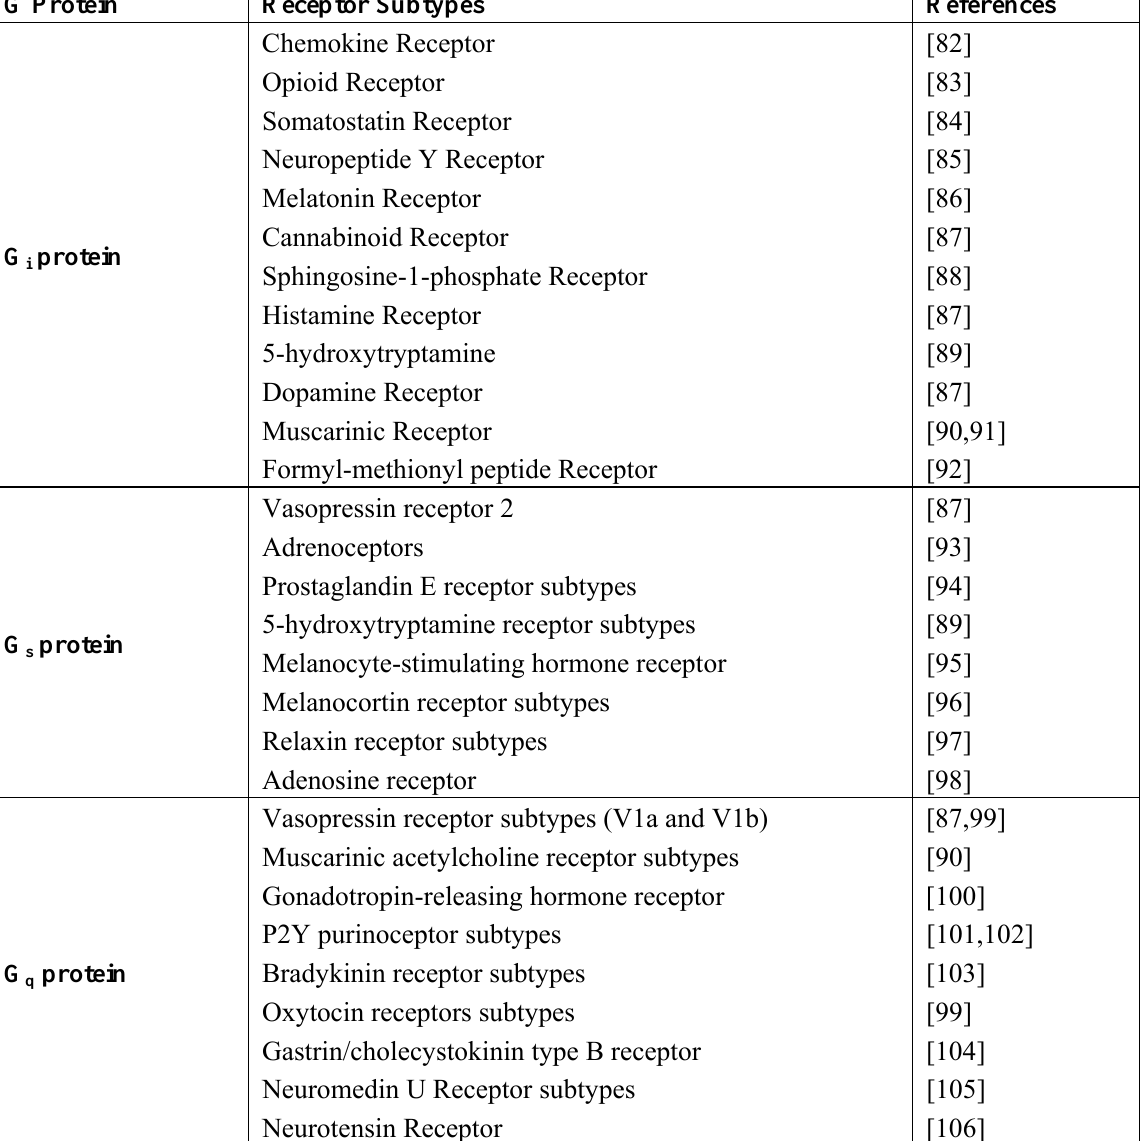
Table 2. Examples of GPCRs coupling to certain G Protein subclasses (G G